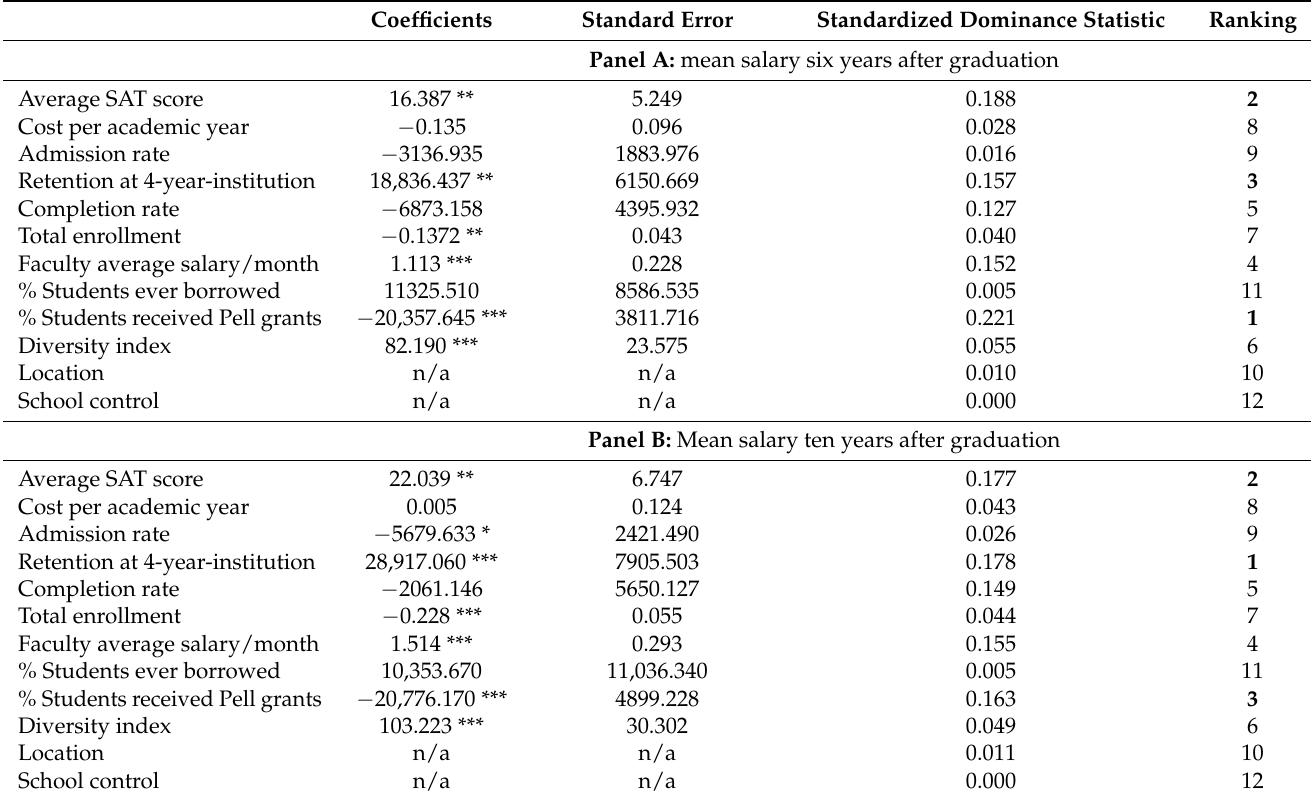
Table 5. OLS Coefficients and importance of predictors of student long-term outcomes and school rankings using Model 3, College Scorecard